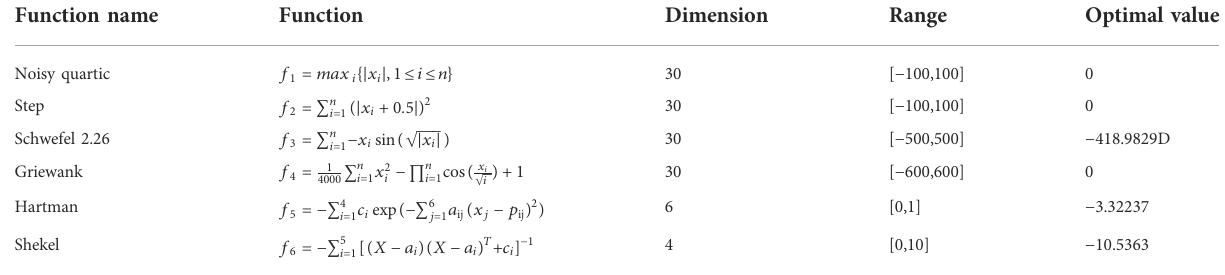
TABLE 2 Benchmark test function set.